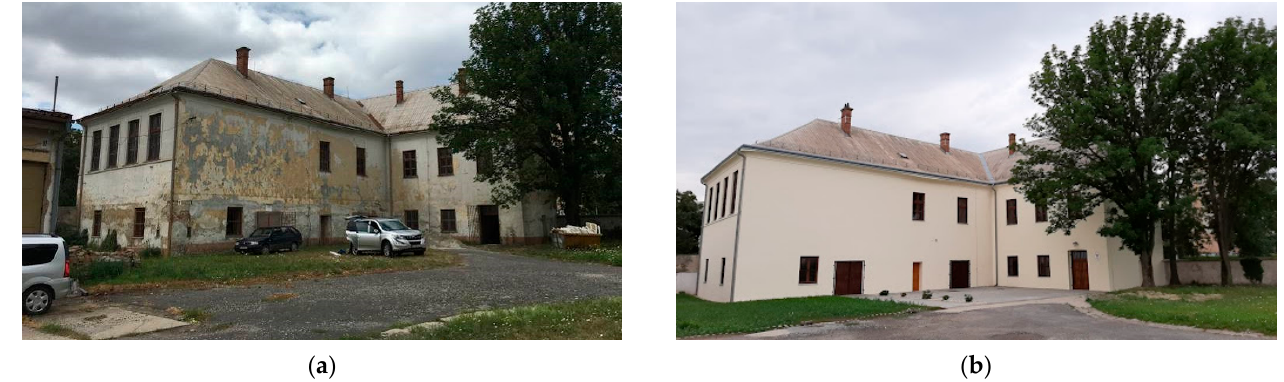
Figure 5. View on the state of building ( a ) before and ( b ) after recovery.